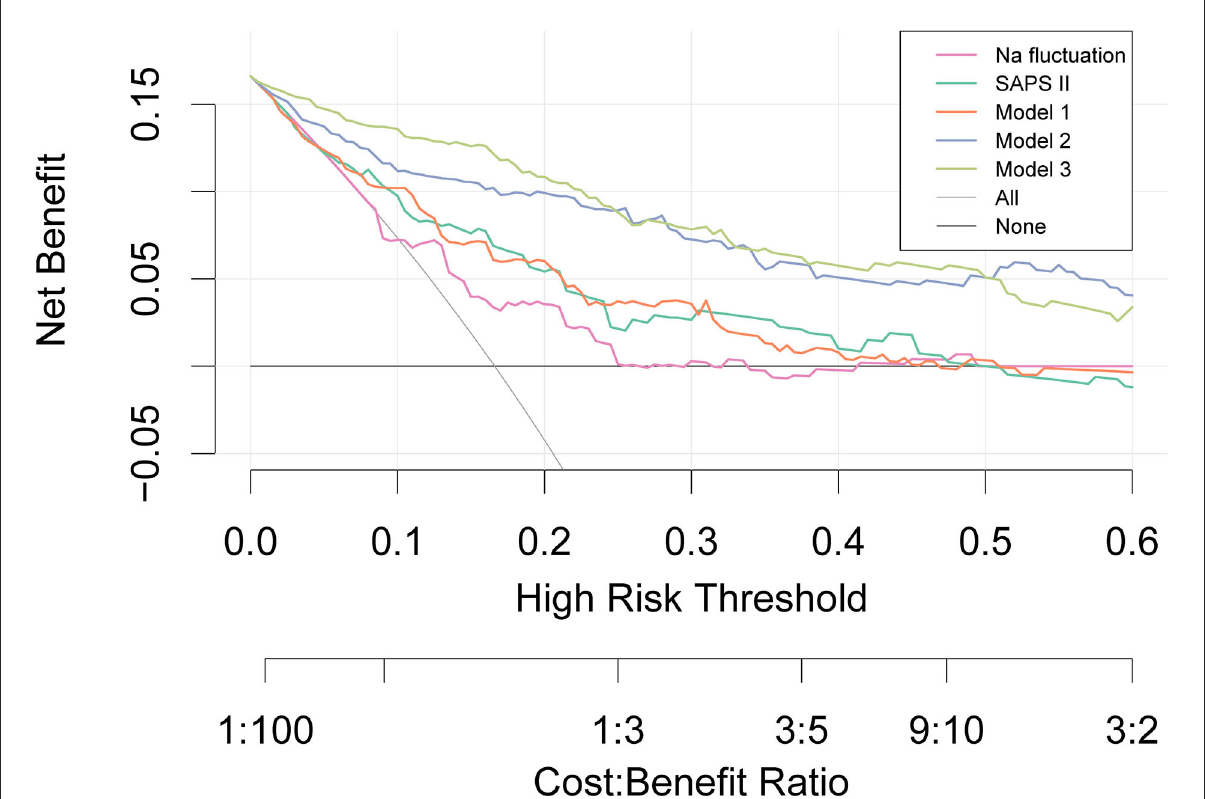
FIGURE4 Decision curve analysis. The X-axis indicates the threshold probability for the outcome and the Y-axis indicates the net benefit. Model 1 adjusted for sex, age, and ethnicity. Model 2 adjusted for congestive heart failure, renal disease, respiratory rate, K, Cl, Na, and minimum Na in addition to covariates in Model 1. Model 3 adjusted for ventilation and vasoactive agent in addition to covariates in model 2. SAPS, Simplified Acute Physiology